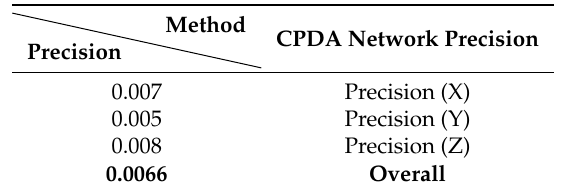
Table 2. Precision of the combined network adjustment between the two epochs for displacement monitoring via CPDA methodology (in meters).